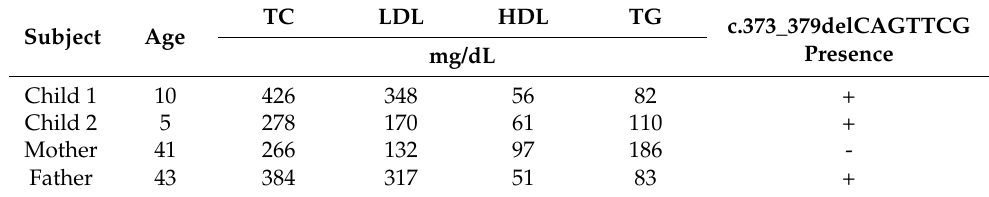
Figure 3. Sanger sequencing chromatogram confirms a heterozygous c.373_379delCAGTTCG variant in the exon 4 of the LDLR gene. Table 4. Lipid concentration values of described siblings and their parents. Table 4. Lipid concentration values of described siblings and their parents.